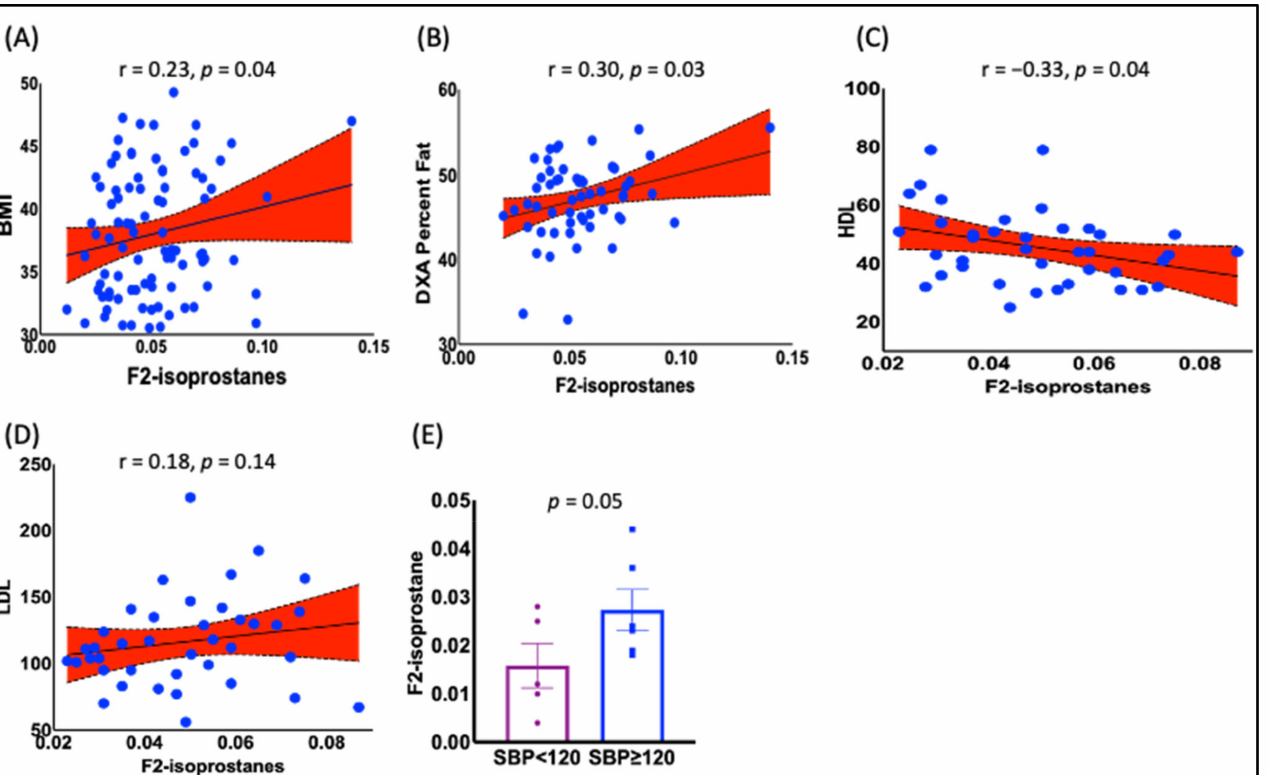
Figure 3. Relationship between BMI and other anthropometric DXA measurements and F 2 -IsoPs. Our data show a positive correlation between ( A ) BMI and F 2 -IsoPs (r = 0.23, p = 0.04).